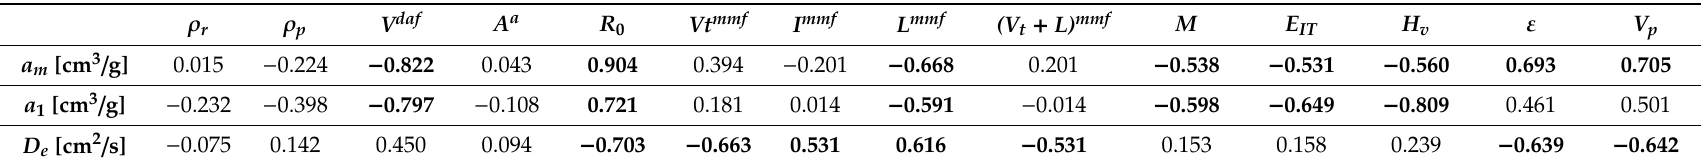
Table 2. Pearson correlation coe ffi cient for correlation between sorption and petrophysical parameters of the tested coals. Statistically significant correlations (for p < 0.05) are presented in bold type.